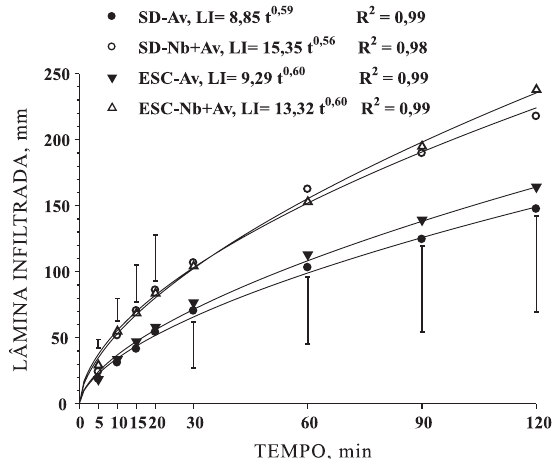
Figura 4. Lâmina de água infiltrada em um